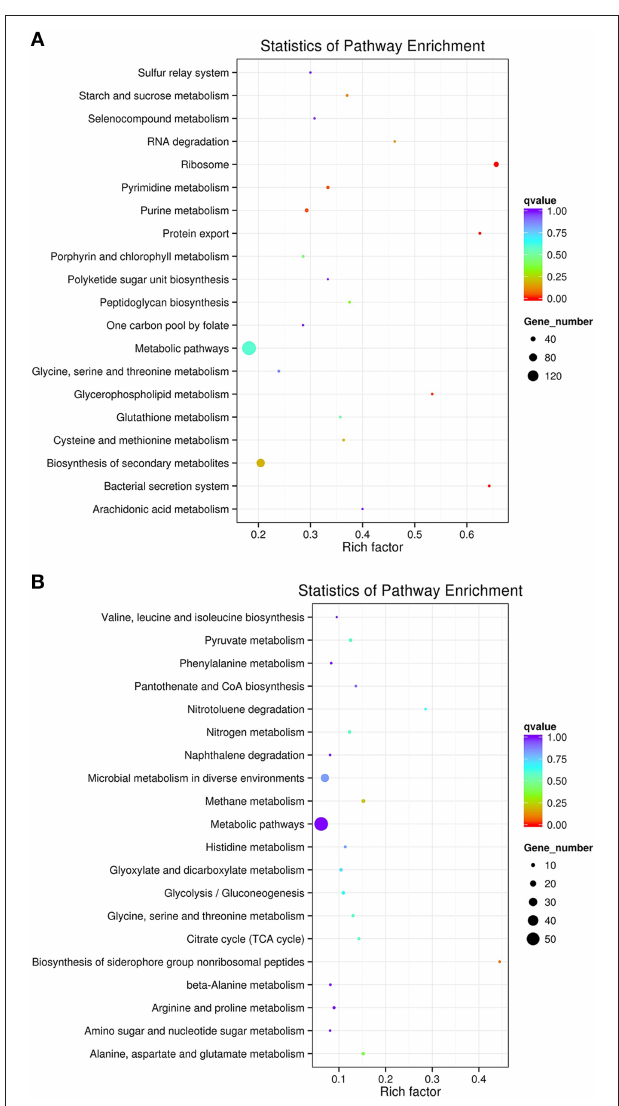
FIGURE 2 | The scatter plot of KEGG pathways enriched for differential expression genes. Panel (A) shows up-regulated pathways. Panel (B) shows down-regulated pathways. The Y-axis is different KEGG pathway. The X-axis is the number of rich factor. The color of circles stands for the q -value of pathway. The range of q value is from 0 to 1. The size of circles stands for gene number. Some up-regulated genes associated to ribosome, protein export, bacterial secretion system, glycerophospholipid metabolism, and RNA degradation were enriched. Some down-regulated genes associated to siderophore non-ribosomal peptides and nitrotoluene degradation were